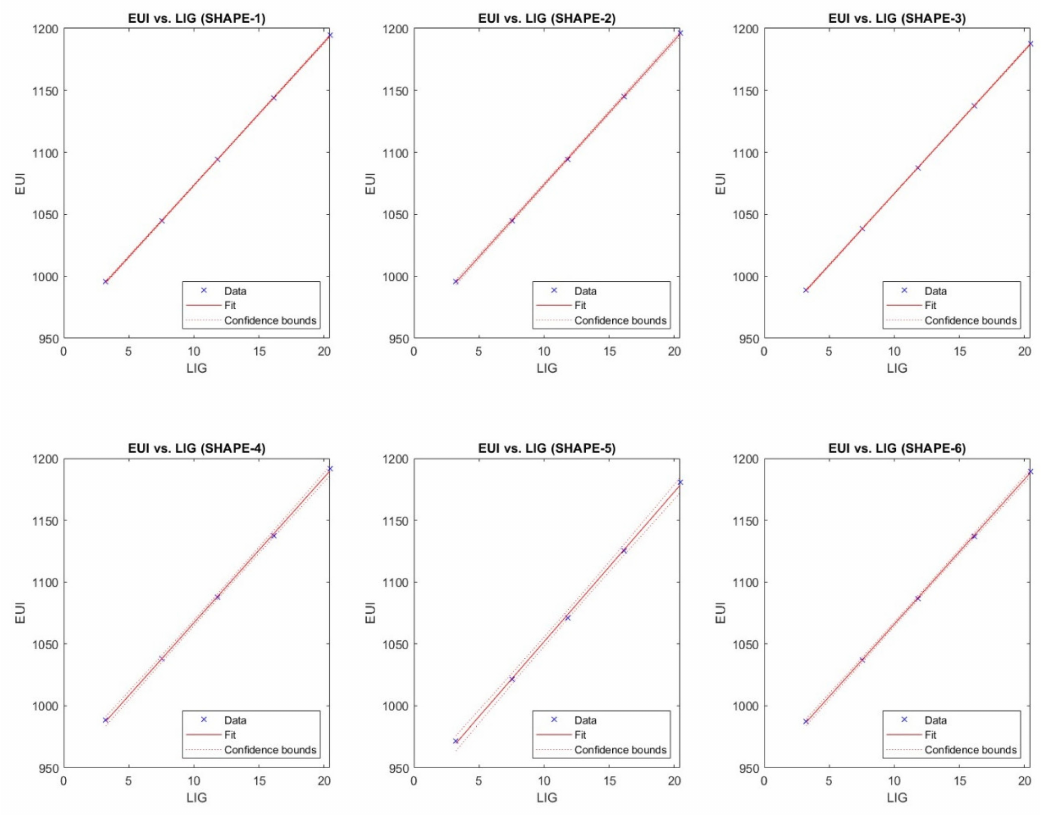
Figure 16. Fitted lines of lighting efficiency.